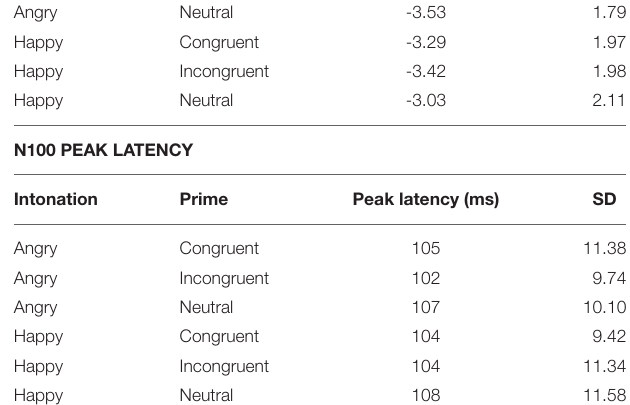
FIGURE 2 | Event-related potentials averaged over all included electrodes for the three congruency conditions and the incongruent - congruent difference, time-locked to target onset. The time window for N100 analysis is shaded in gray. The scalp potential map shows the incongruent - congruent difference in the N100 time window.